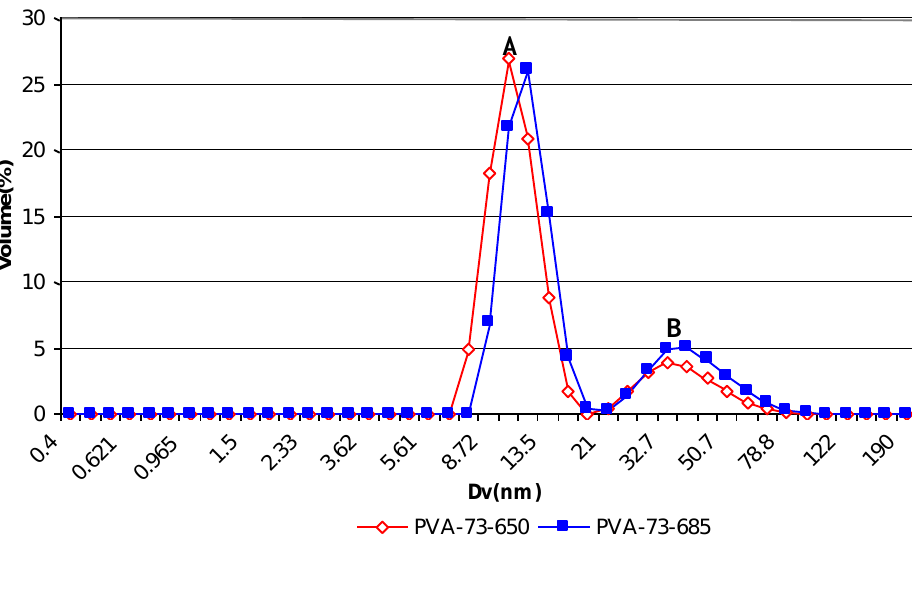
Figure 1. DLS-size distributions: Dv for the non-fractionated samples PVA-73-650 and PVA-73-685. A representing the “free chains” and B the nanogels